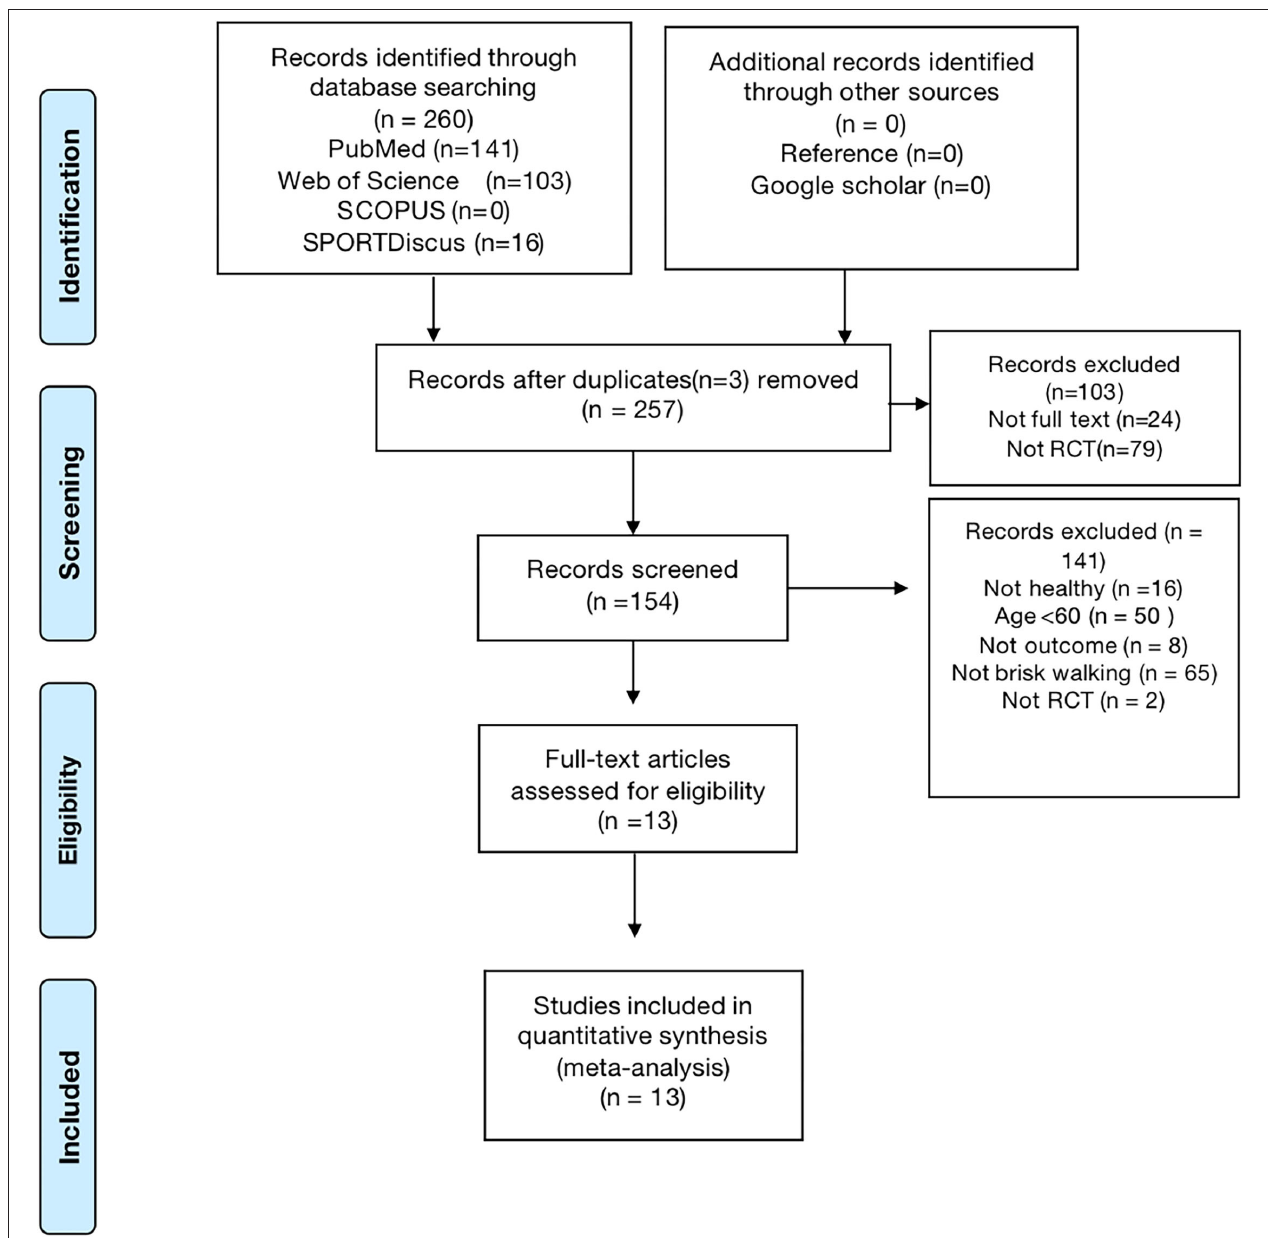
FIGURE 1 | PRISMA flow chart of the study selection